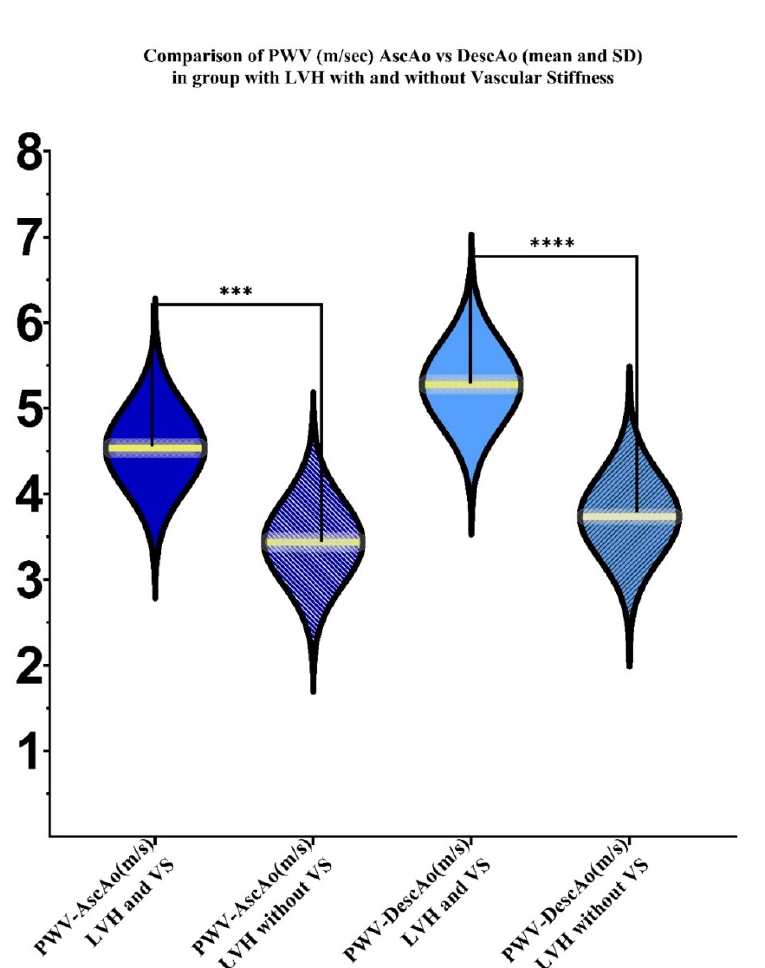
Figure 5. Violin plot of PWV values in the AscAo and DescAo, in groups with LVH with vascular stiffness (VS) and without vascular stiffness, by two-way ANOVA. p < 0.001, (***), p < 0.0001 (****).